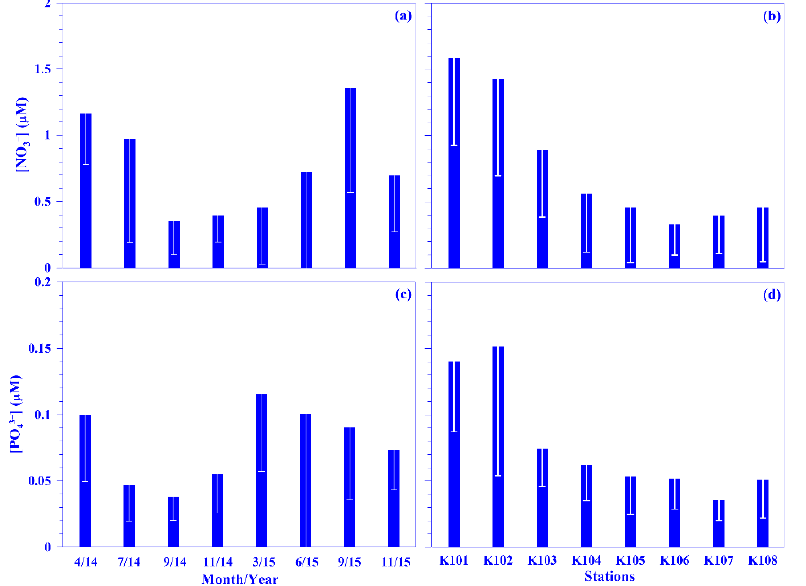
Figure 3. Temporal and spatial variations of the mean values of nitrate (NO 3 − ; ( a , b )) and phosphate (PO 4 3 − ; ( c , d )) across the KTV1 transect of the Kuroshio. The depth-normalized integrated value over 100 m water column of each variable at each sampling station was used for the mean values. The mean values were averaged across all stations of the KTV1 transect for each sampling period or across each station of the KTV1 transect for all sampling periods. The standard deviations are illustrated as vertical white lines with